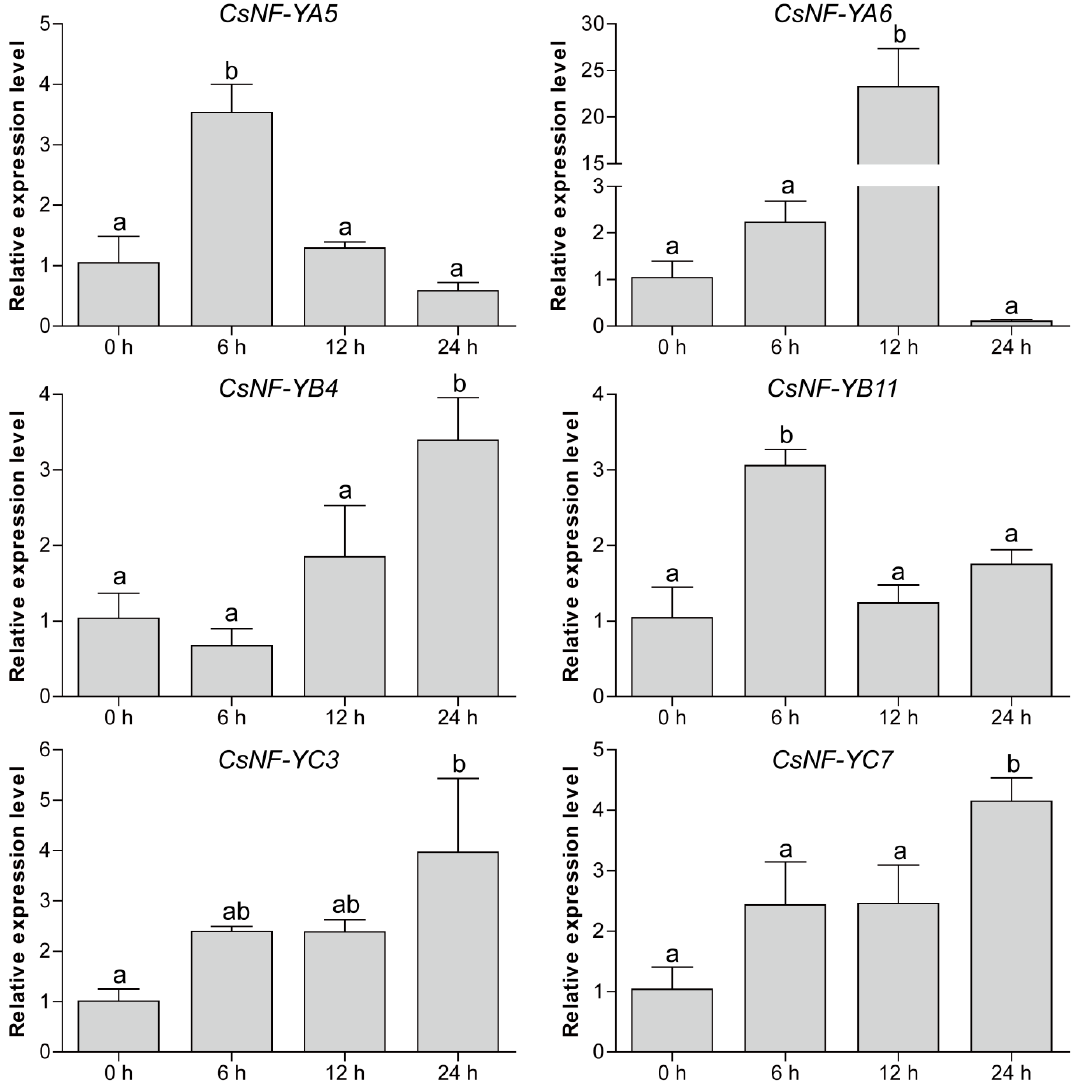
Figure 6. qRT-PCR expression analysis of six selected CsaNF-Y genes in response to salt stress. Vertical bars indicate the standard error of the mean, and different letters are significantly different.